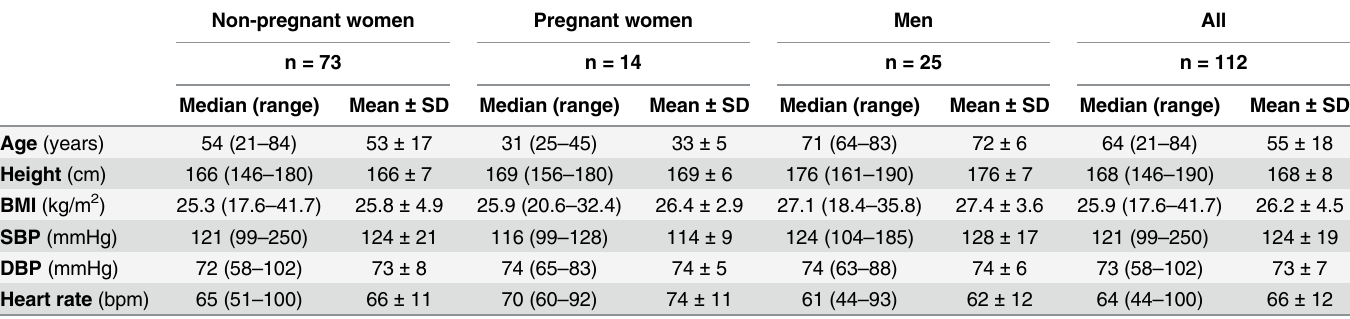
Table 1. Demographic characteristics of the study